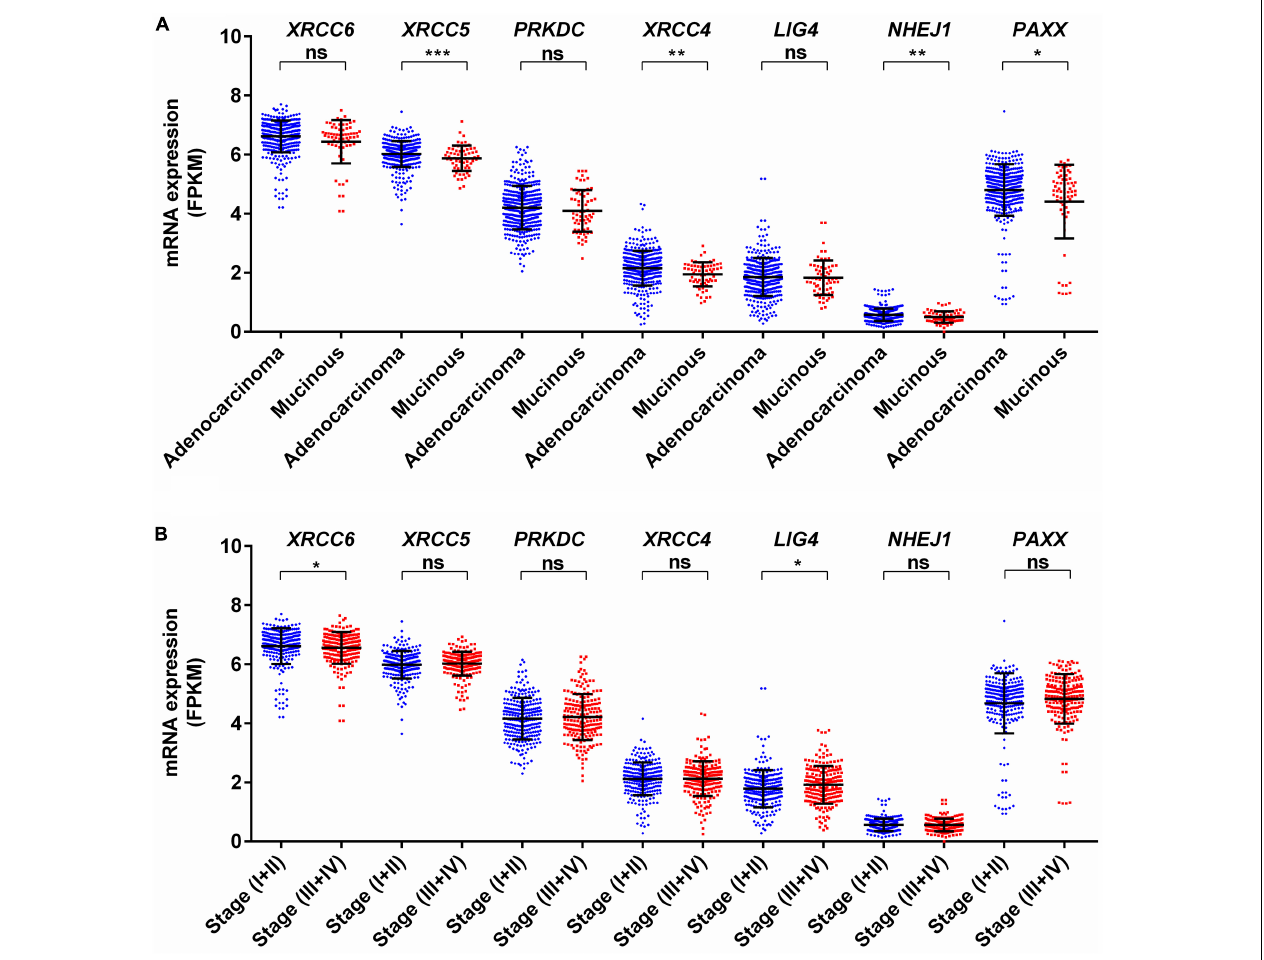
FIGURE 3 | Association of mRNA expression of NHEJ pathway genes with (A) tumor histology, and (B) stage. * p < 0.05, ** p < 0.01, *** p < 0.001, **** p < 0.0001. FPKM, Fragments per kilo million bases.